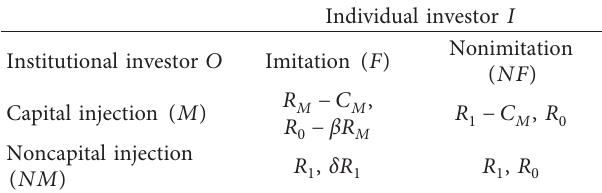
Table 1: Payoff matrix of the evolutionary